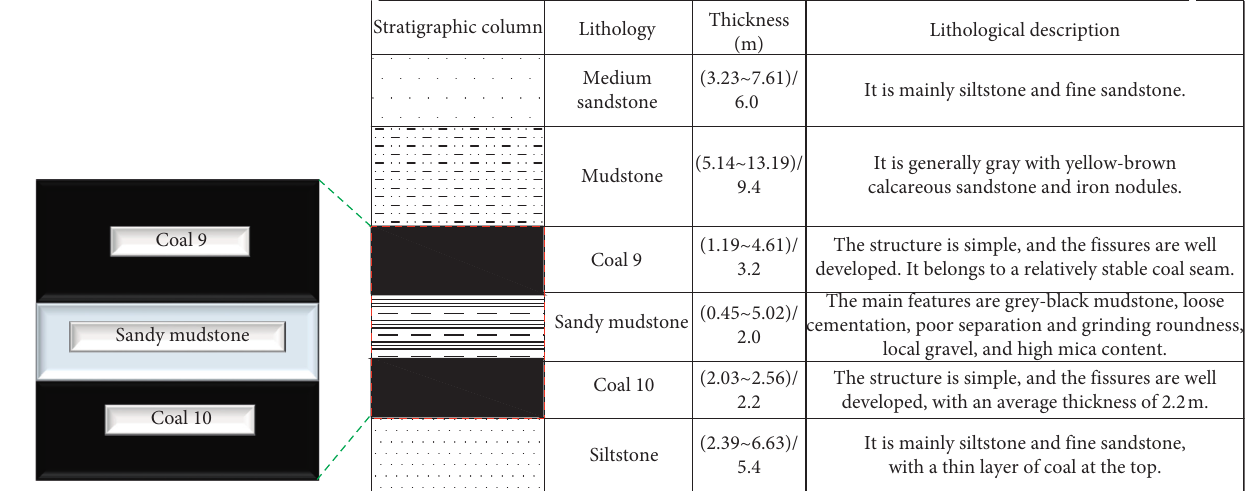
Figure 2: Generalized stratigraphy column of the test site.